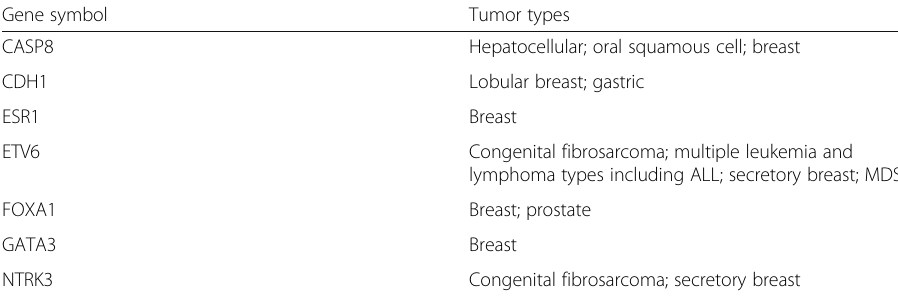
Table 2 Breast cancer-related genes Gene